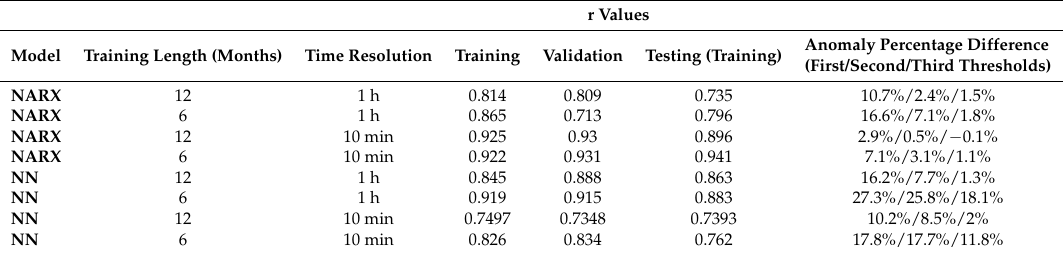
Table 2. Comparison of models’ anomaly detection performance from case study 1.